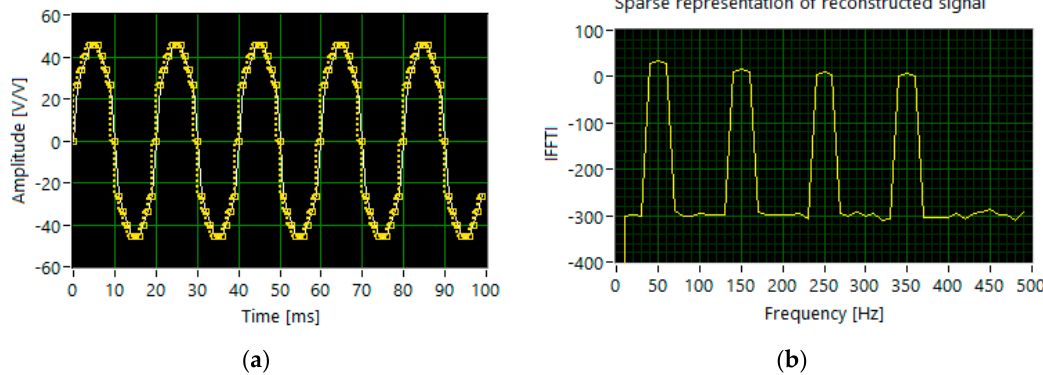
Figure 7. The results of simulation for set 2: ( a ) the segments of time waveforms of the original (white line) and reconstructed signal (dotted yellow line); ( b ) DFT components of the reconstructed signal.